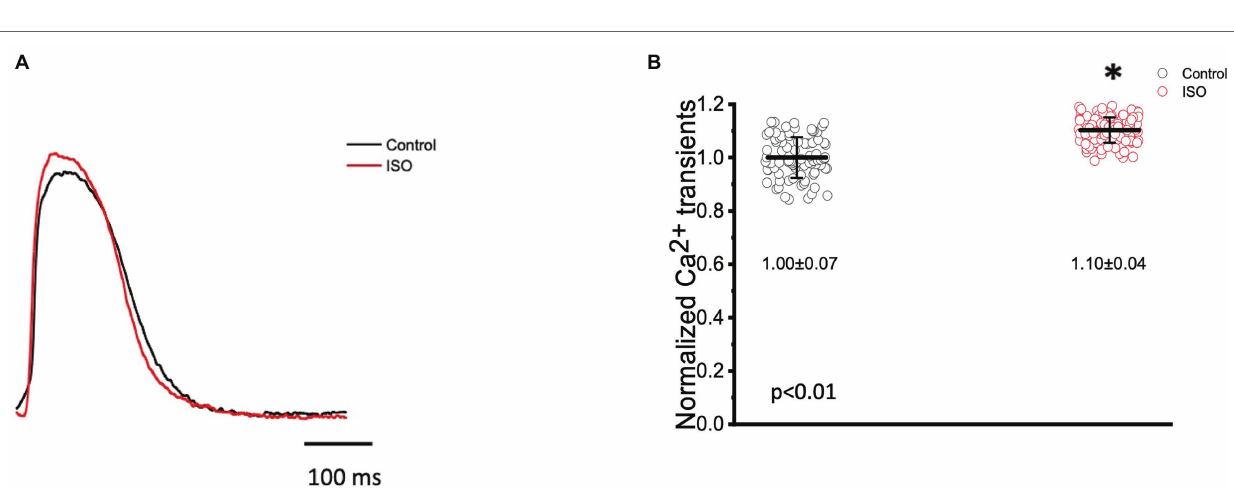
FIGURE 5 | Goldfish ventricular Ca 2+ transient recording and normalized amplitude in the absence (black) and presence (red) of 100 nm isoproterenol. Stimulation of 𝛽 -adrenergic receptors altered the morphology of the Ca 2+ transient (A) and significantly increased the normalized amplitude of the Ca 2+ transient from 1.00 ± 0.07 to 1.10 ± 0.04 ( p < 0.01, n = 65 for the control, n = 67 for ISO, N = 8; B ). * Denotes a significant difference between the two distributions. The data are presented as multiple measurements (n; dot cloud) recorded for different measurements ( n ) on different hearts ( N ) with the mean ± SEM (solid